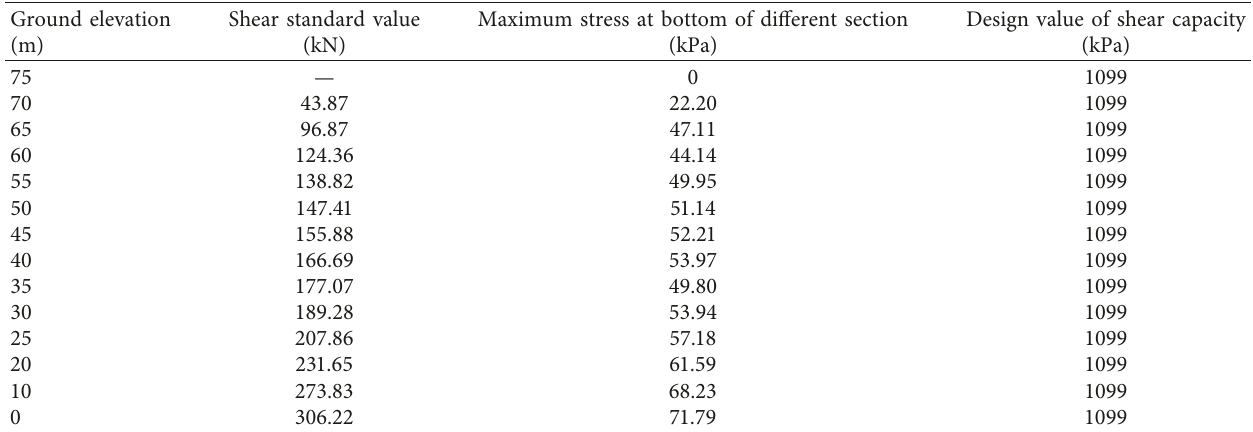
Table 9: Maximum shear stress under the action of a horizontal